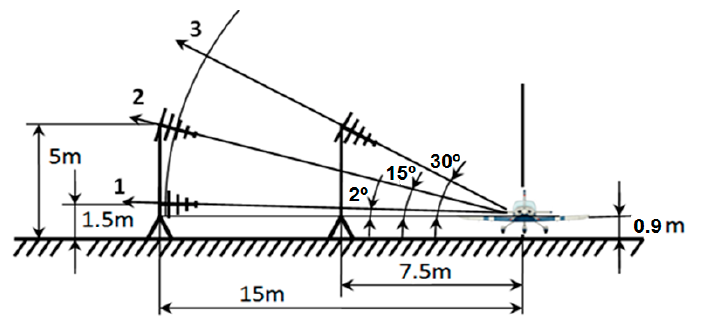
Figure 10. Position measurement angles of θ = (2°, 15°, and 30°).